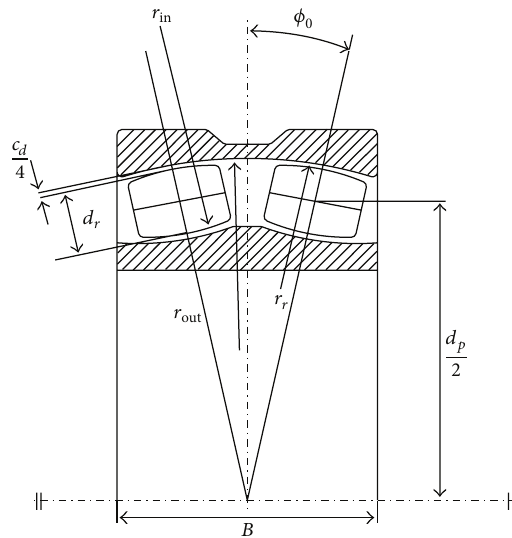
Figure 1: Geometric parameters of spherical roller bearing